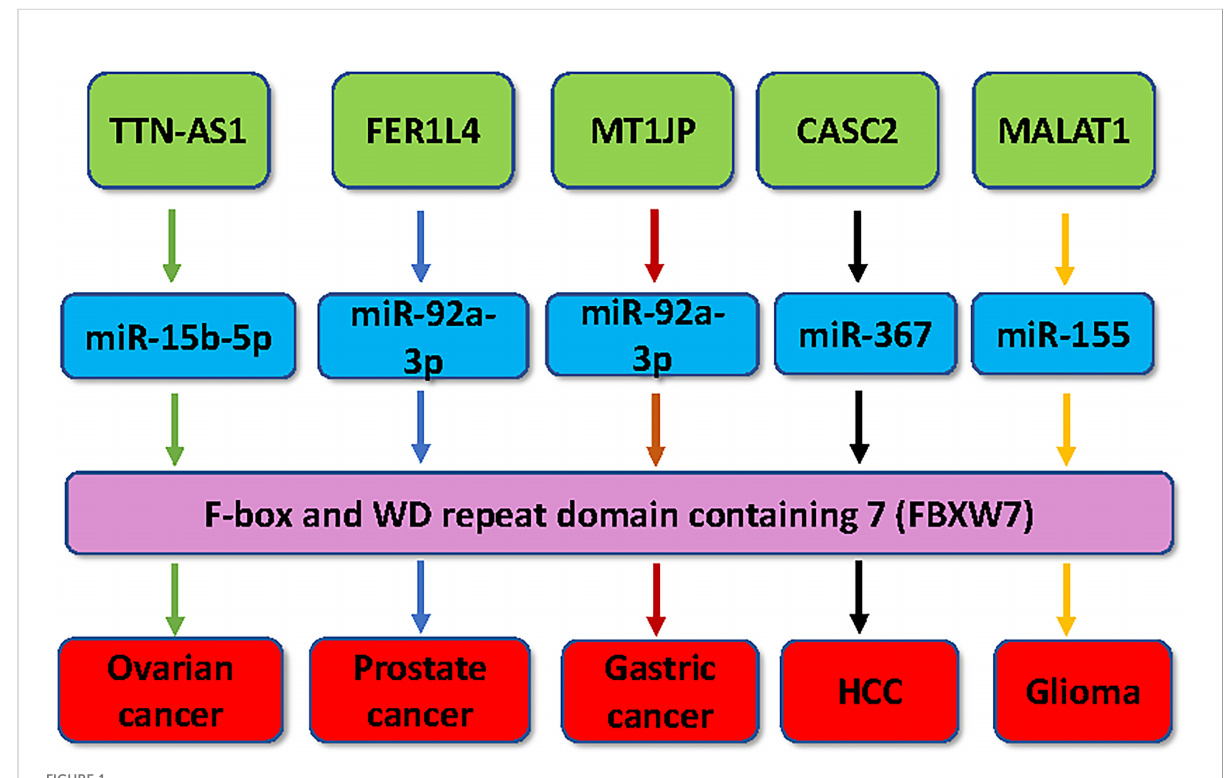
FIGURE 1 Multiple lncRNAs regulate the expression of FBXW7 in human cancer. Multiple lncRNAs, including MT1JP, FER1L4, TTN-AS1, CASC2 and MALAT1, have been demonstrated to regulate the expression of FBXW7 in